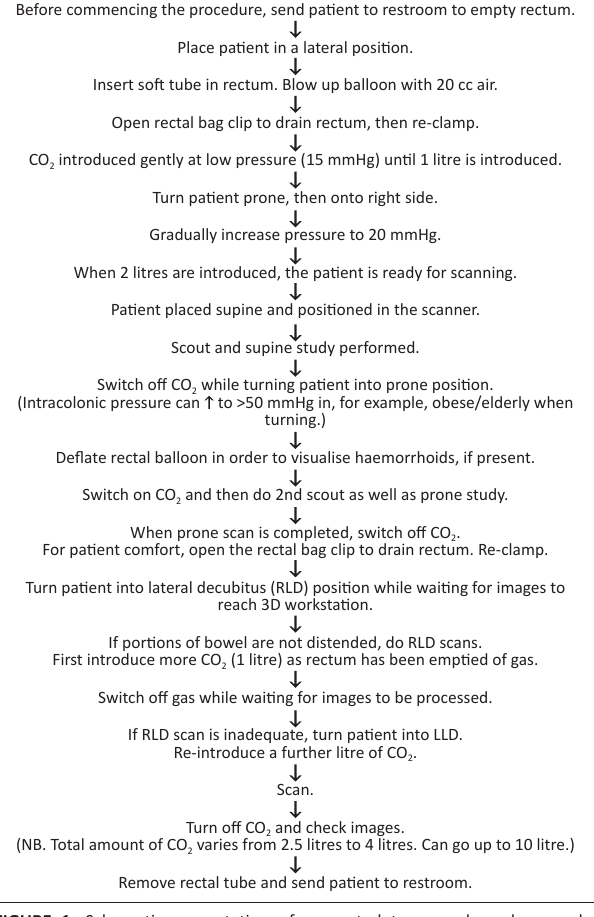
FIGURE 1: Schematic presentation of computed tomography colonography (CTC) technique.